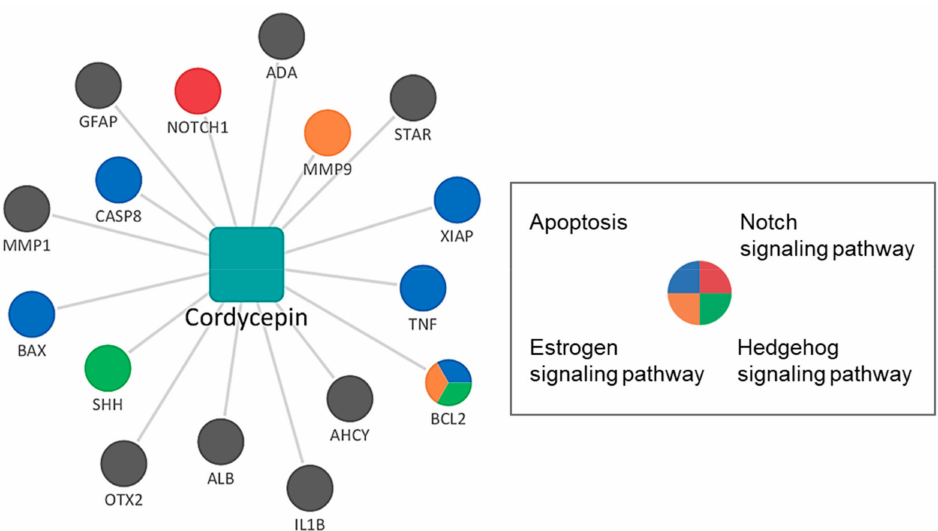
Figure 2. Compound–target network of Cordyceps militaris . Rectangles represent the compounds, and circles represent the targets. Nodes related to apoptosis, estrogen, hedgehog, and notch signaling pathway in KEGG and validated targets by western blotting analysis are colored. ADA, adenosine deaminase; AHCY, adenosylhomocysteinase; ALB, albumin; BAX, BCL2 associated X, apoptosis regulator; BCL2, BCL2 apoptosis regulator; CASP8, caspase 8; GFAP, glial fibrillary acidic protein; IL1B,